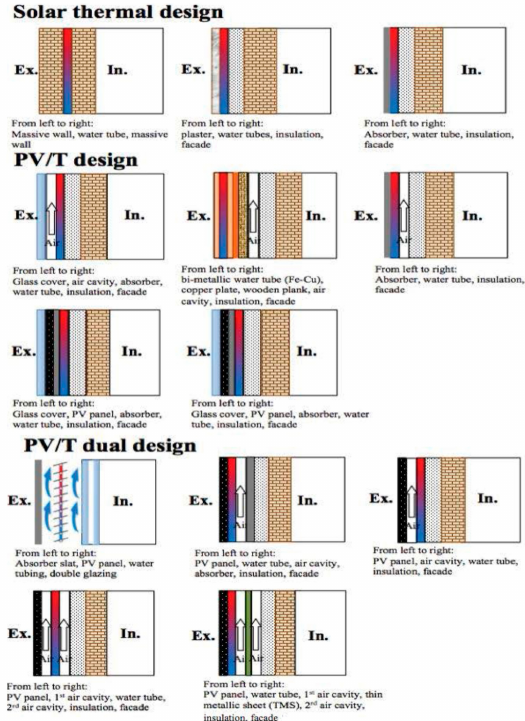
Figure 8. Schematics of different water-based Building integration with PV-thermal